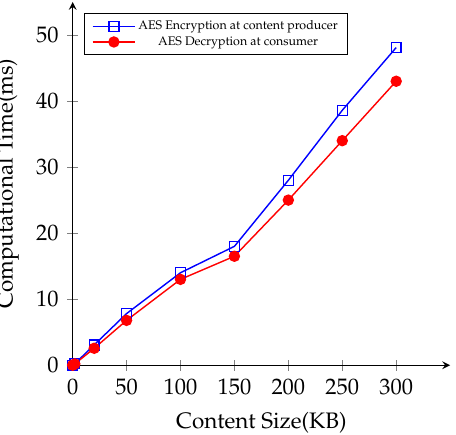
Figure 9. Average computational time cost for AES operations with different file